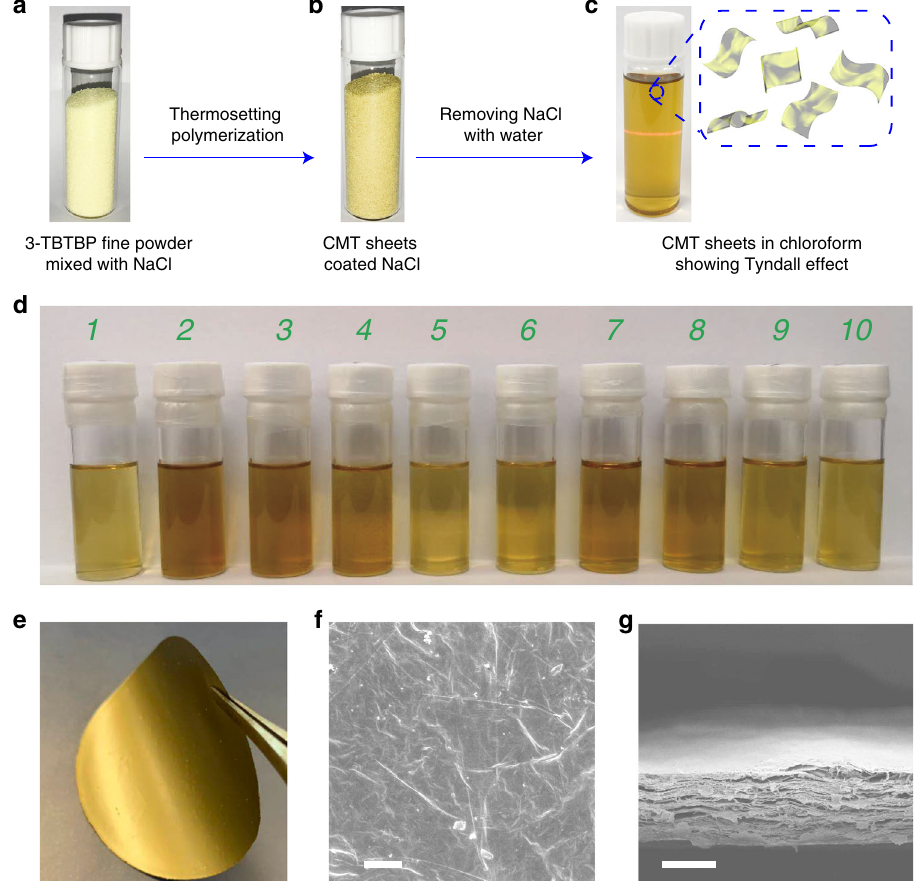
Fig. 2 Synthesis and characterization of CMT membrane. a An optical image of a mixture of 3-TBTBP precursor fi ne powder and NaCl crystals. b An optical image of CMT coated NaCl. c CMT/Chloroform dispersion showing a Tyndall effect. d CMT dispersions (concentration: 0.05 mg ml − 1 ); solvent: (1) dichloromethane, (2) ethanol, (3) methanol, (4) hexane, (5) diethyl ether, (6) acetone, (7) dimethylformamide, (8) dimethyl sulfoxide, (9) tetrahydrofuran, and (10) isopropanol. e A free-standing CMT membrane with a diameter of ~47 mm prepared by fi ltration. f A SEM image showing the surface of a CMT membrane. g A SEM image showing the cross-section of a free-standing CMT membrane. The scale bars are 2 μ m and 10 μ m for f and g ,